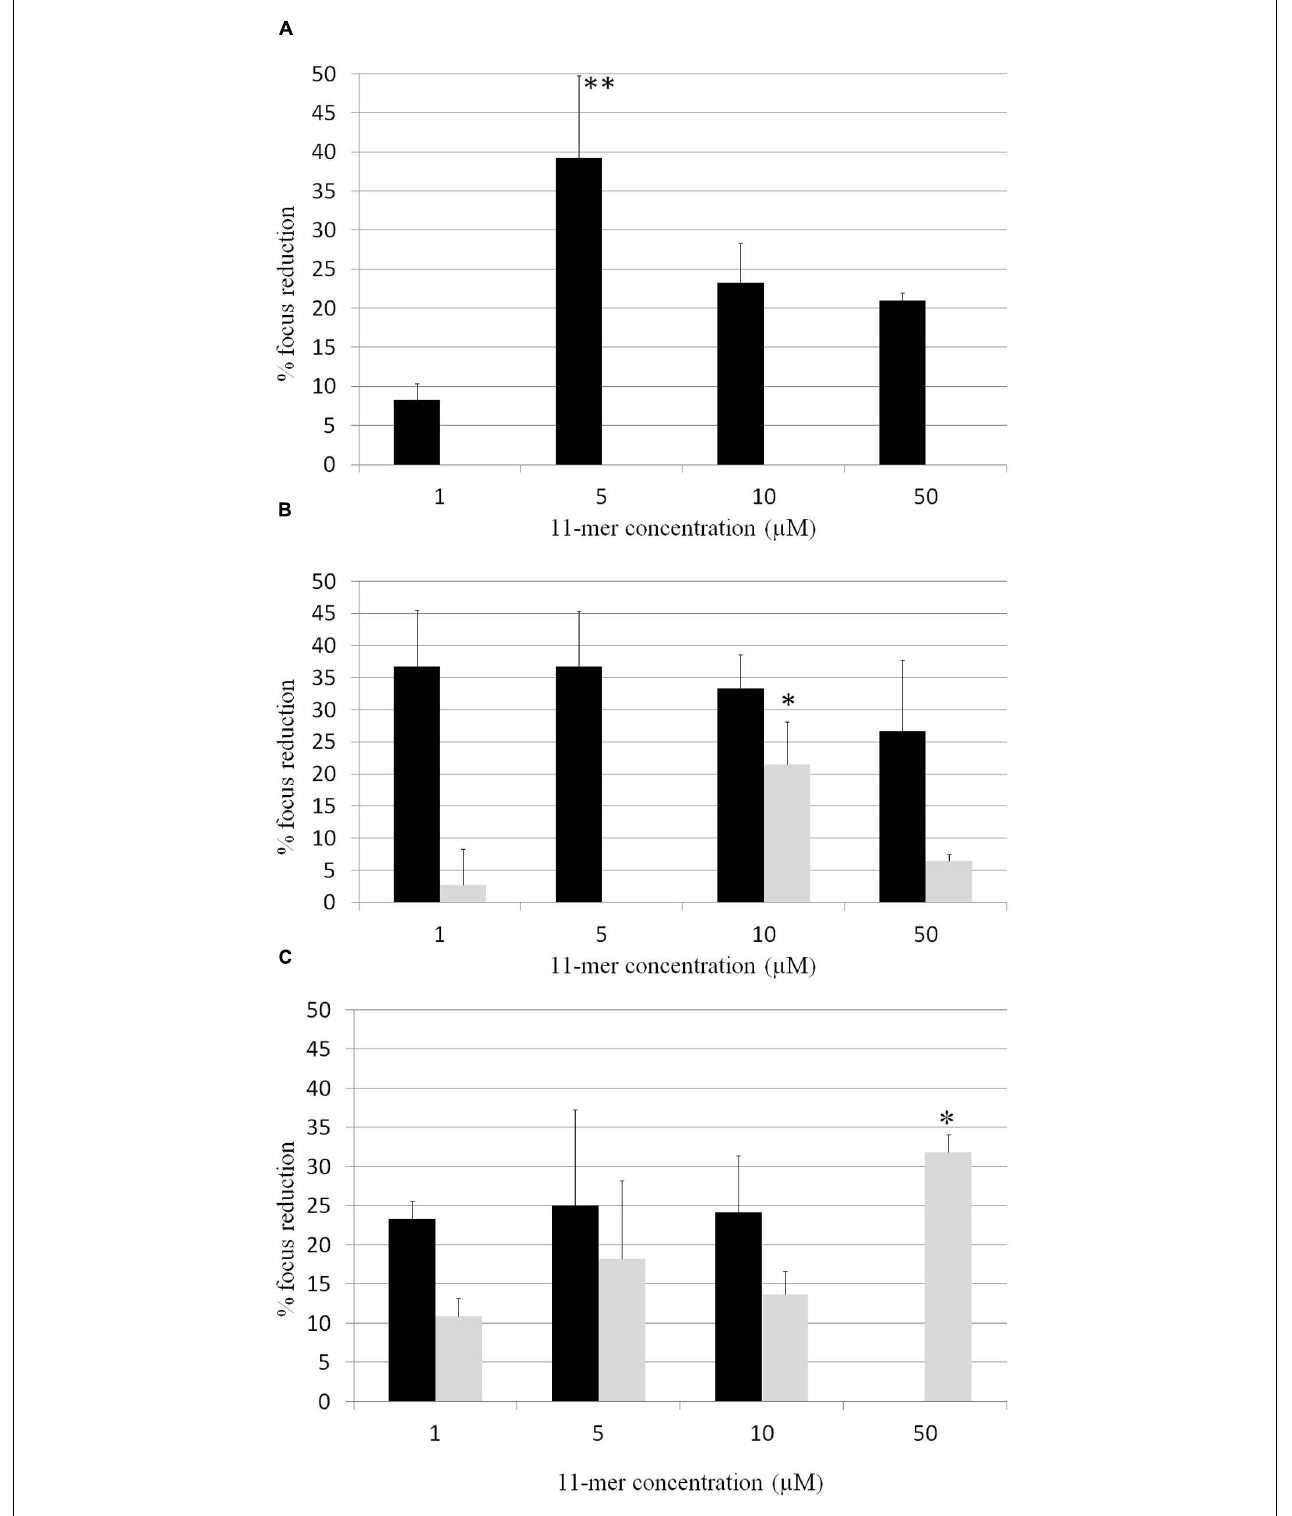
FIGURE 3 | Percentage of focus reduction in human rotavirus infection by strategy B, in which 11-mer peptide was incubated with the cell cultures followed by the inoculation of the virus. Black bars correspond to MA-104 cell line and gray bars to HT-29 cell line. (A) Wa virus assays; (B) Ito virus assays; (C) VA70 virus assays. Data are the average of at least two independent experiments. Error bars represent the standard errors for replicates. ∗ P -value < 0.01; ∗∗ P -value < 0.001.